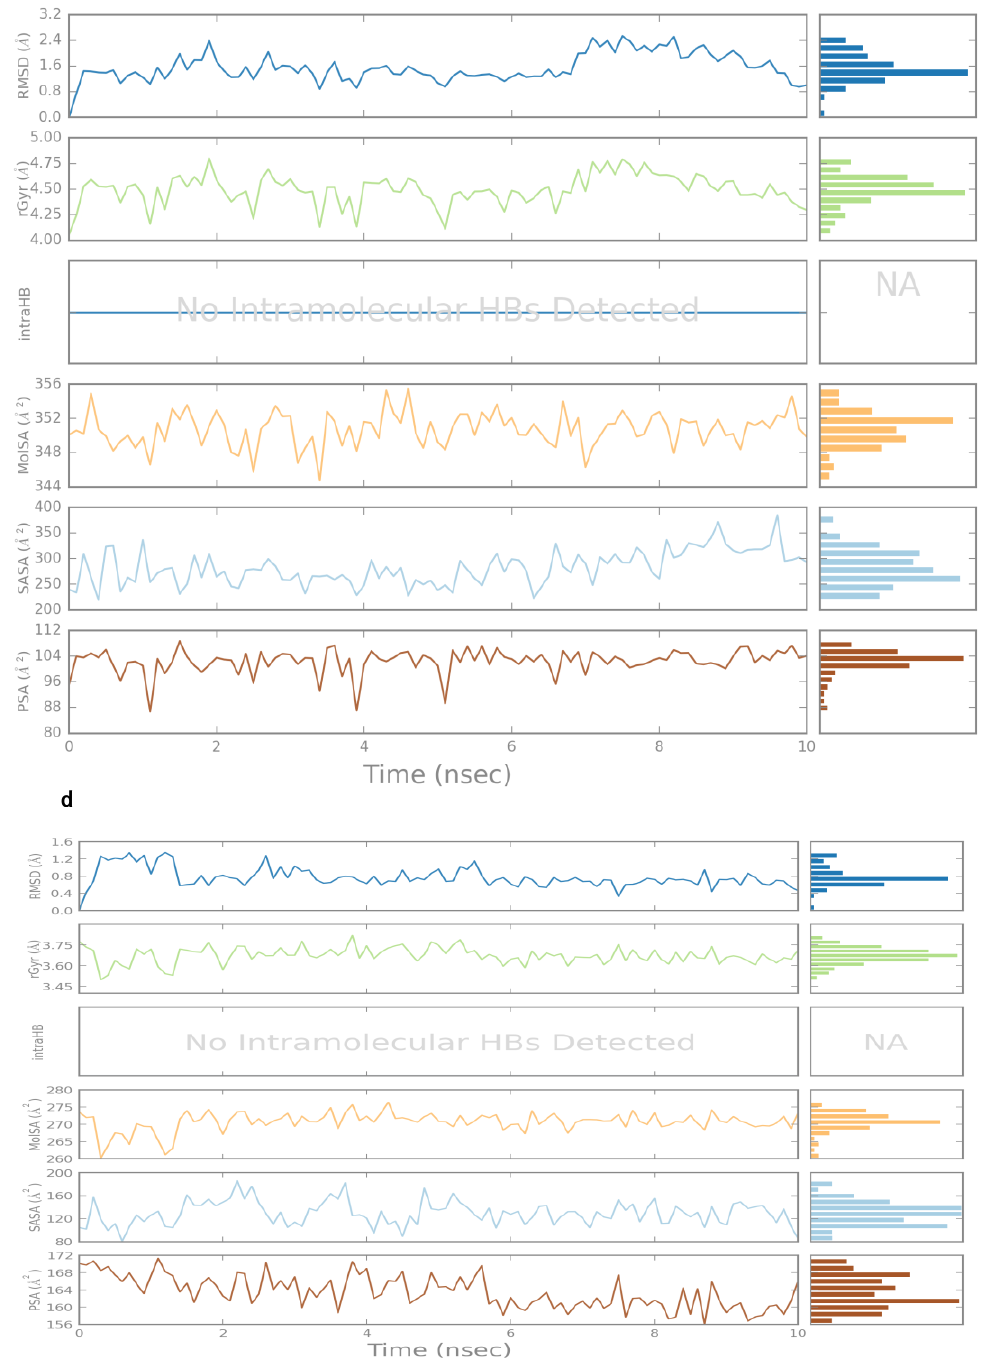
Figure S12. Ligand (a) 10 (b) 19 (c) 21 and (d) 25 properties during MD simulations (0.00 through 10.00 ns). RMSD: Root mean square deviation of a ligand with respect to the reference conformation; rGyr: Radius of Gyraion which measures the 'extendedness' of a ligand; intraHB: Intramolecular Hydrogen Bonds; MolSA: Molecular Surface Area; SASA: Solvent Accessible Surface Area; PSA: Polar Surface